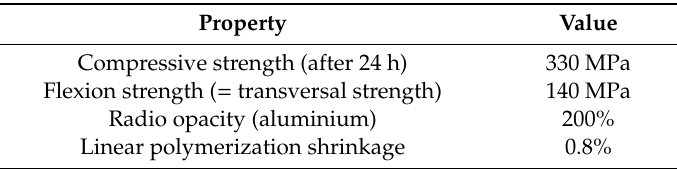
Table 2. Physical properties (experimental cement).